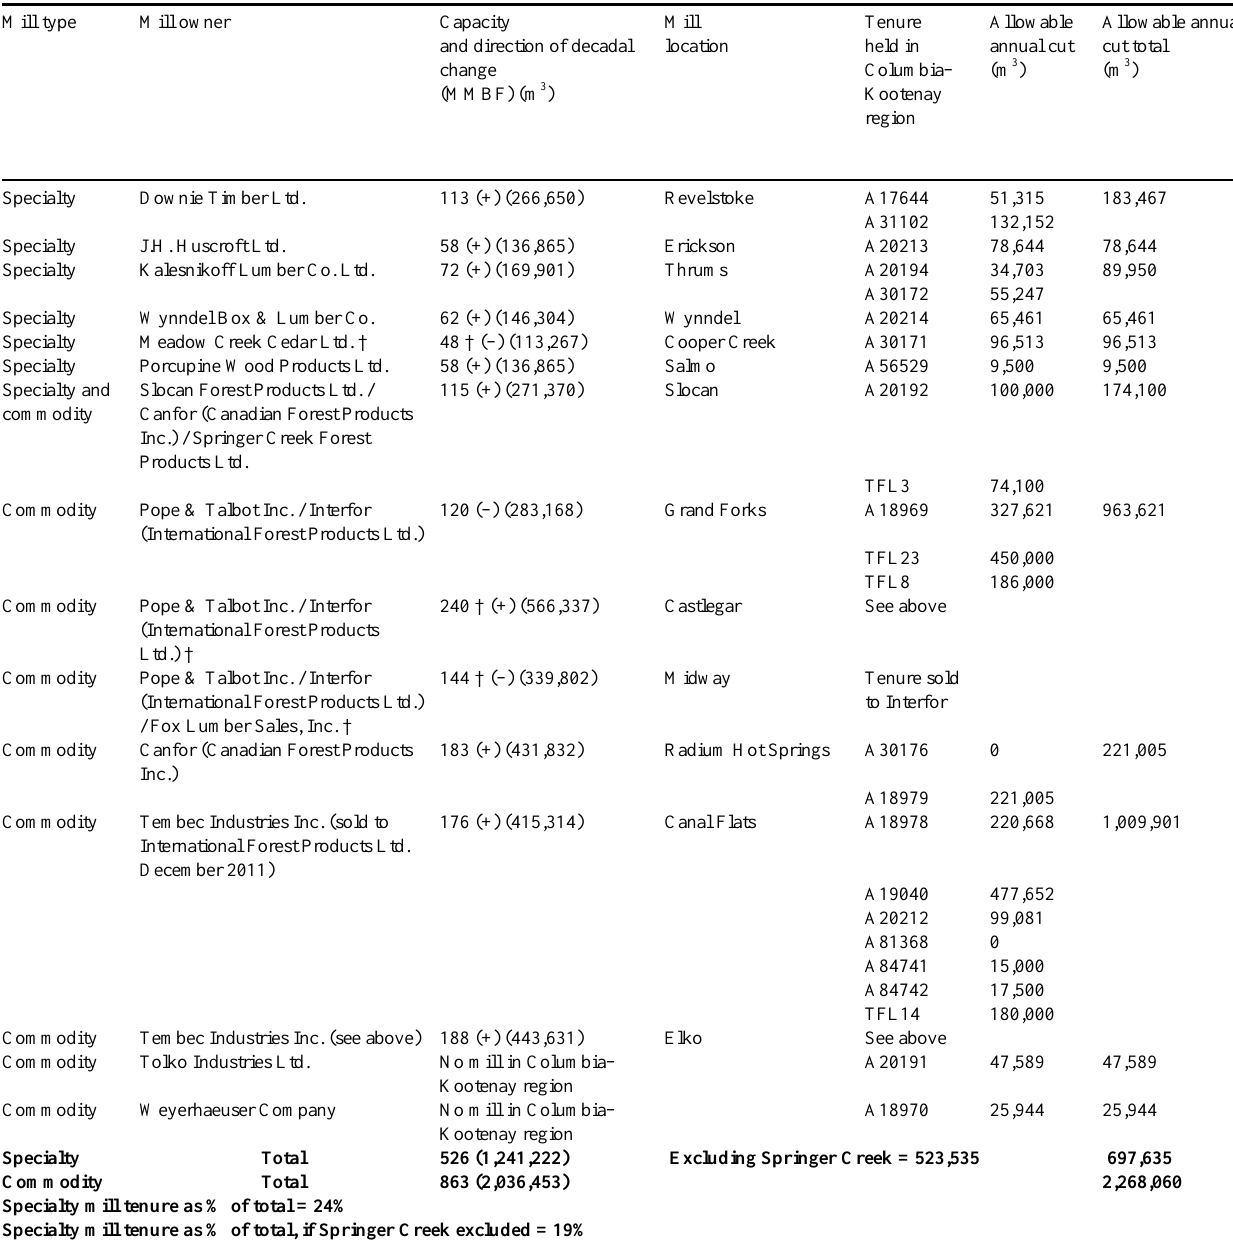
Table 1 . Specialty and commodity sawmill capacity and tenure held in the Columbia-Kootenay Region (British Columbia Ministry of Forests, Lands and Natural Resource Operations